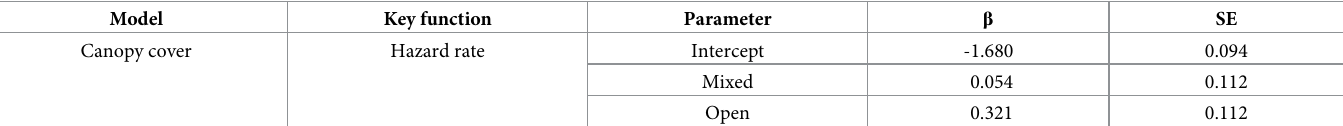
Table 2. Parameter estimates for the most parsimonious detection model for surveying white-tailed deer via helicopter during 2016 in Adirondack Park, New York. Cover was a categorical variable and, when significant in a model, hardwood cover served as the reference category. Shown are β coefficients and standard error (SE). Model